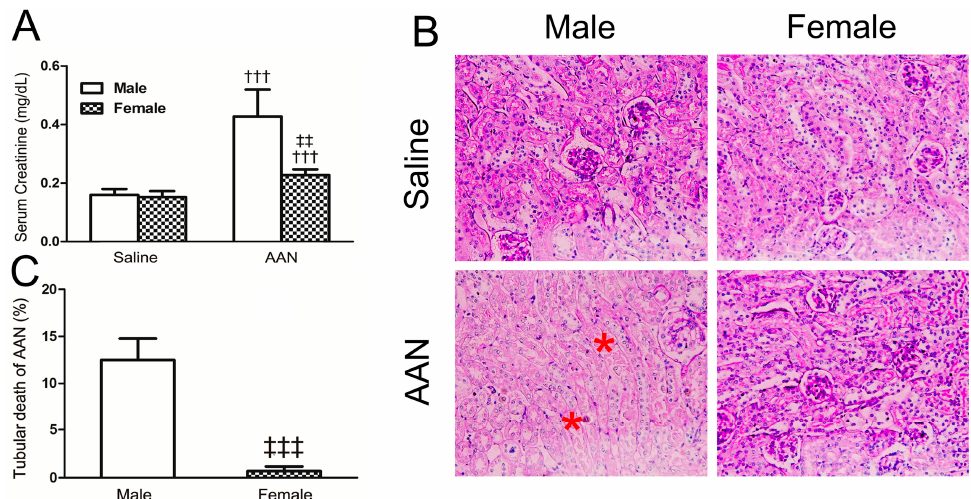
Figure 2. AA-induced acute AAN in mice at day 5. ( A ) Serum creatinine at day 5 after induction of acute AAN; ( B ) Histology (PAS-stained sections) at day 5 after induction of acute AAN. Note that there were many tubules with typical coagulative necrosis morphology (asterisk) in male mice with acute AAN; ( C ) Quantitative analysis of tubular death. Data were expressed as means ± SD for groups of 6 mice. ††† p < 0.001 vs. saline control mice; ‡‡ p < 0.01, ‡‡‡ p < 0.001 vs. male mice with acute AAN. Magnification, ×200.